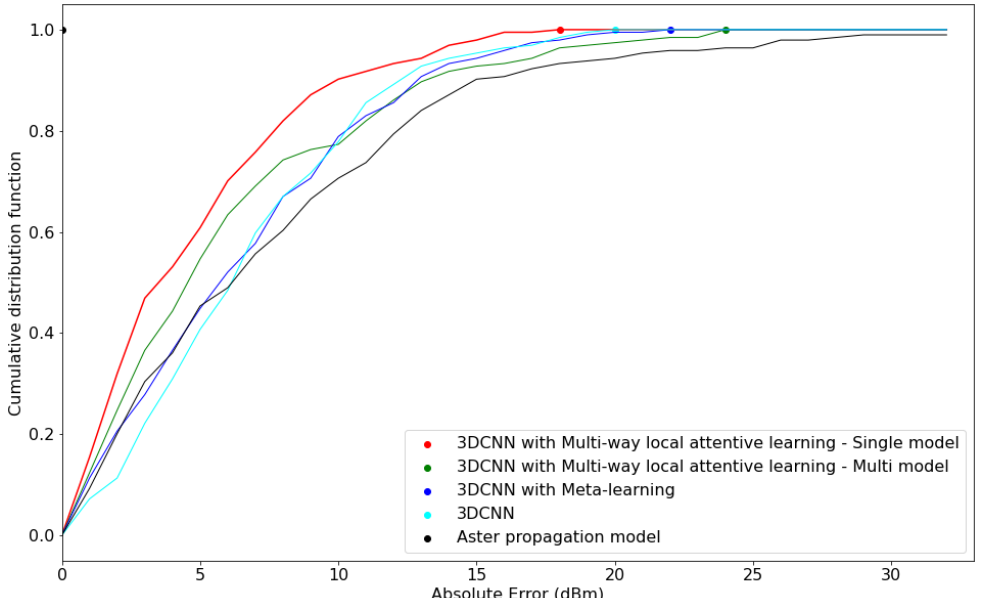
Figure 8. Absolute Error Cumulative Density Function.